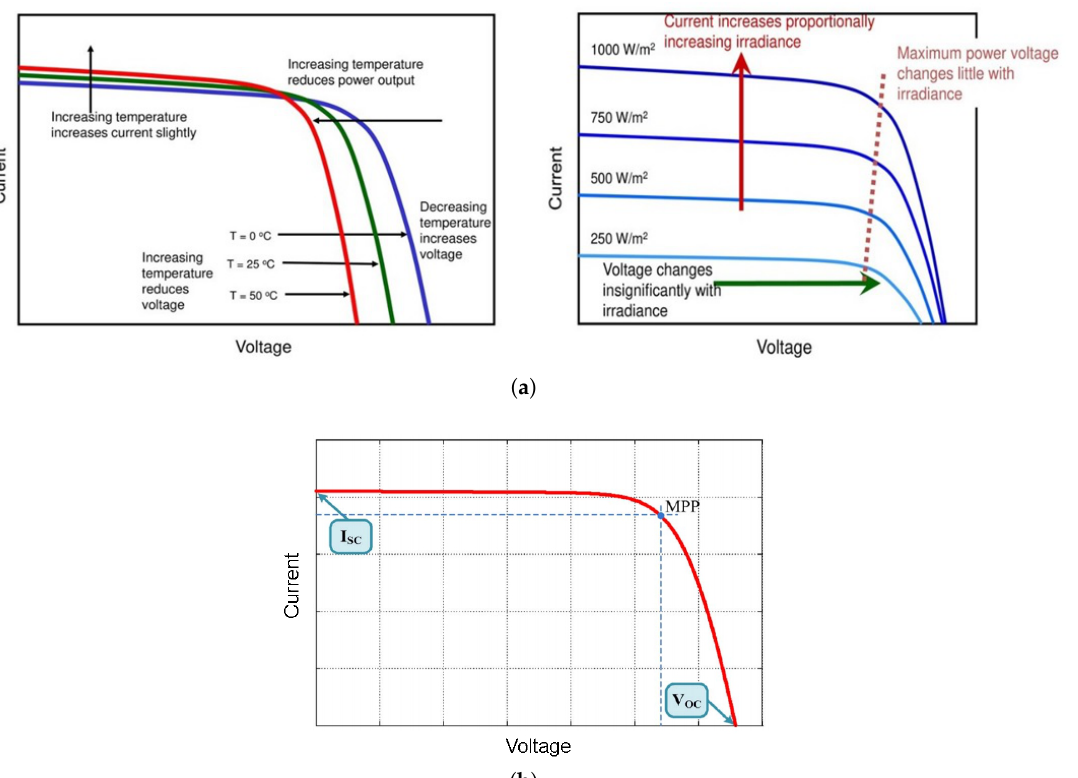
Figure 1. The output voltage and current variations during irradiation and temperature changes. ( a ) PV module voltage-current graphs versus solar irradiance and temperature; ( b ) Maximum power point of a PV